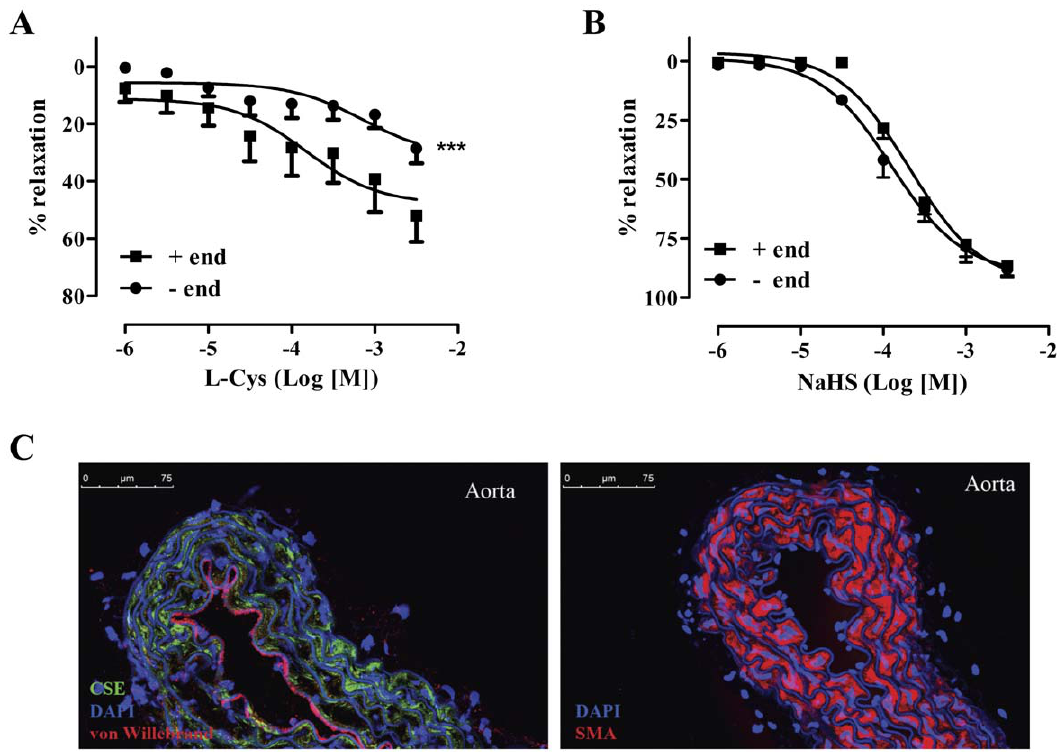
Figure 6. Role of endothelium in H 2 S induced-vasodilatation. (A) L-cysteine-induced vasodilatation was significantly impaired in aortic rings without endothelium (–end). (B) NaHS-induced vasodilatation is not affected by endothelium removal; *** p , 0.001 vs –end, n=6 for each group. (C) Representative photomicrographs of aortas stained with a CSE antibody and counter-stained for von-Willebrant factor, smooth muscle a -actin (SMA) and DAPI, showing localization of CSE.